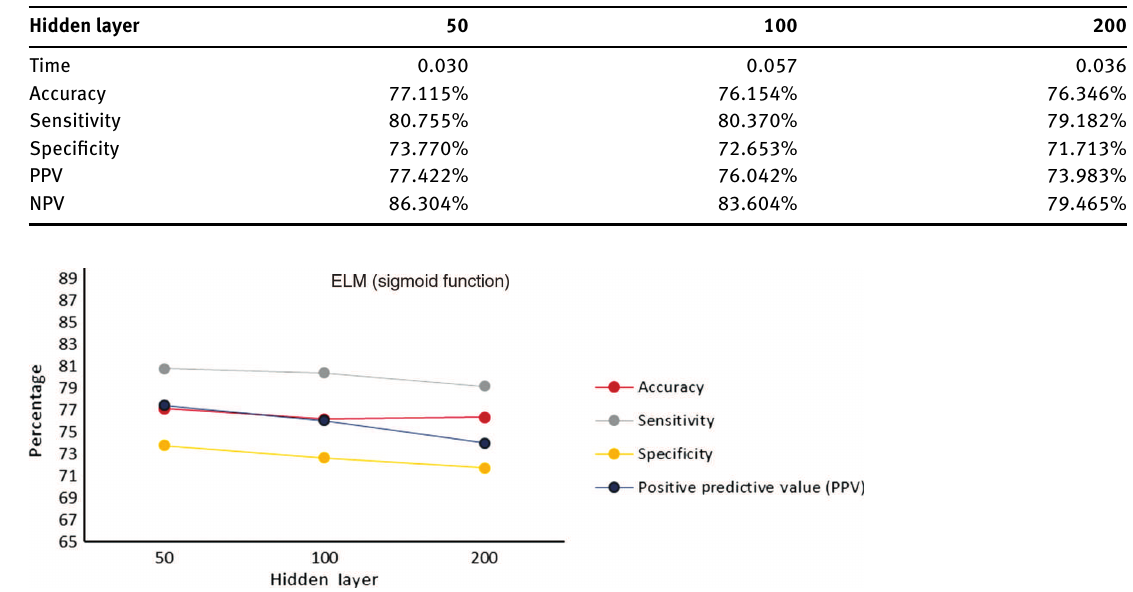
Table 1: Extreme Learning Machine Using Sigmoid Function Result.